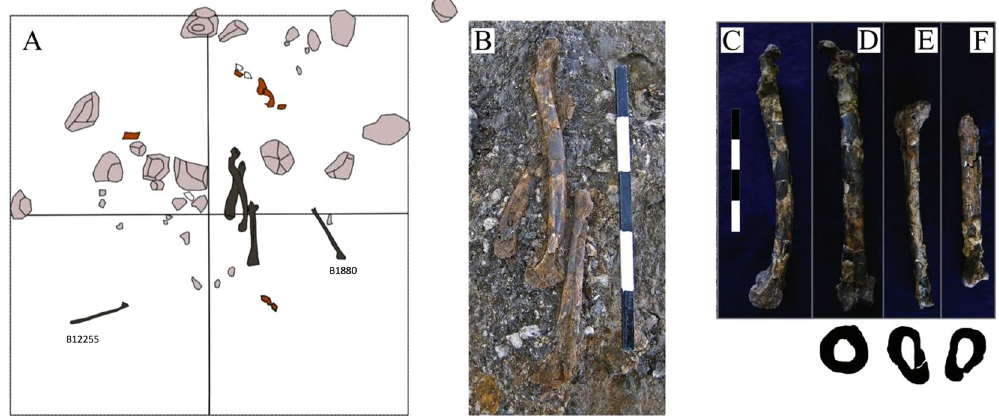
Figure 4. Specimen EQH3. ( A ) The spatial location of the five lower limb bones of EQH3 (dark brown); specimens B1880 and B12255 are fibulae. Pink: stones; reddish-brown: faunal remains. ( B ) The bones in situ . Note the partial articulation of the left femur and left tibia. ( C ) Left femur, medial view. ( D ) Left femur, anterior view; midshaft cross section (underneath). ( E ) Left tibia, anterior view; midshaft cross section (underneath). ( F ) Right tibia, anterior view; midshaft cross section